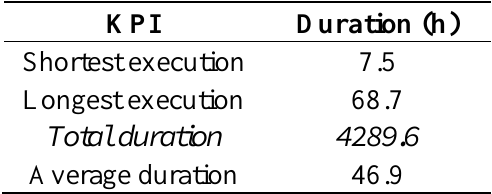
Table 6. KPIs, by using single-valued parameters, for 100